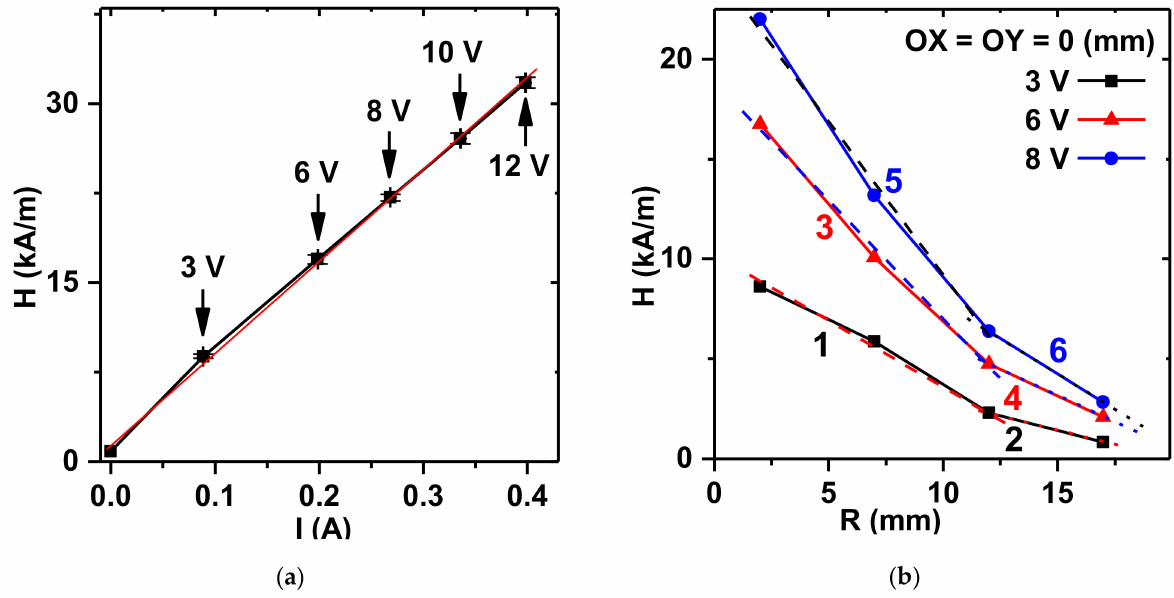
Figure 5. Characteristic plots of the field strength of the electromagnet: ( a ) Dependence of the field in the center of the surface of the magnet on the electric current value. H(I) dependence can be fitted by the equation y = 76.6X + 1.5; ( b ) dependences of the field strength on the distance from the surface. Dependences can be fitted by the following equations: 1 − y = 0.6X + 10.0, 2 − y = 0.3X + 5.8, 3 − y